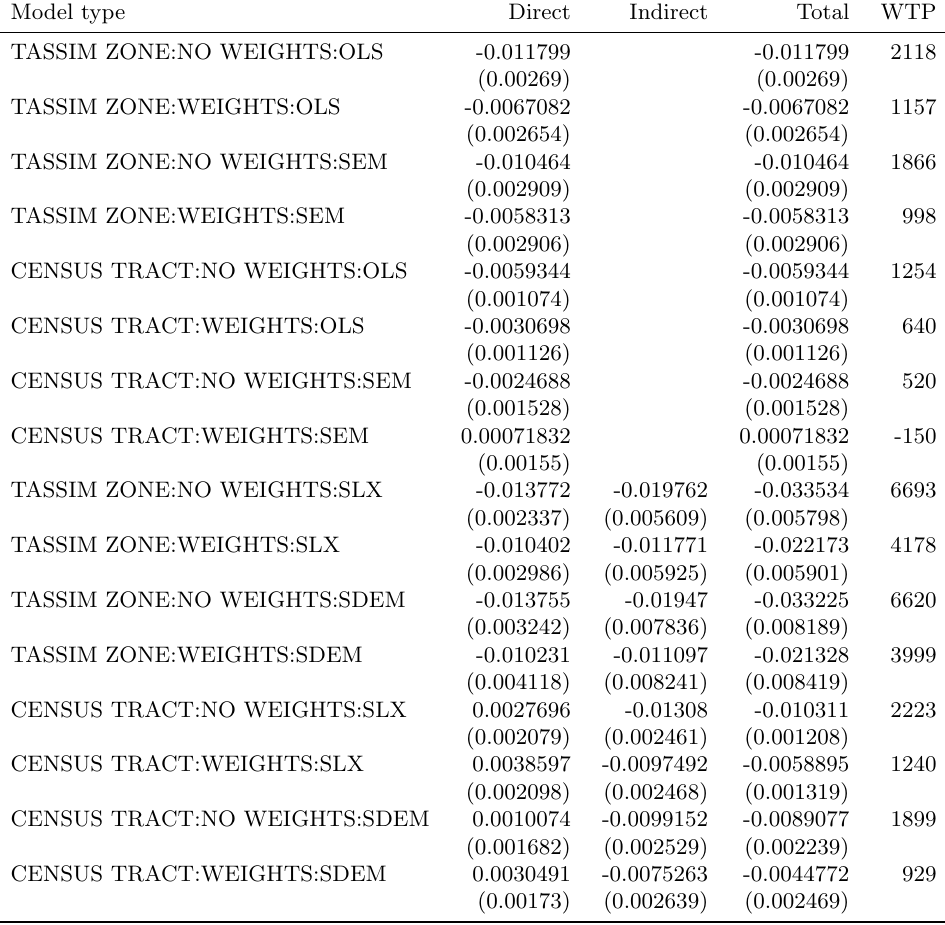
Table A.11: Model NOX coefficient values and impacts, displayed graphically in Figure 3 ( N − k standard errors in parentheses); the final column shows the WTP for a one pphm reduction in NOX also shown in Table